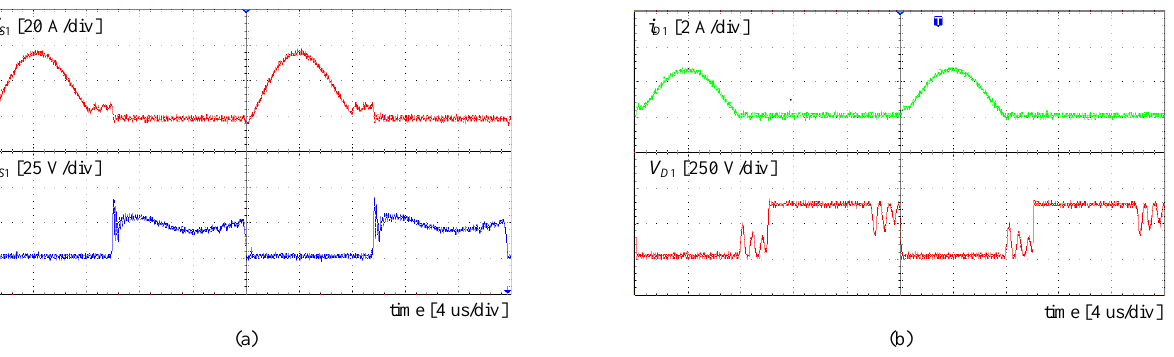
Figure 10. Experimental waveforms: ( a ) current and voltage waveforms of the switch; ( b ) current and voltage waveforms of the diode.